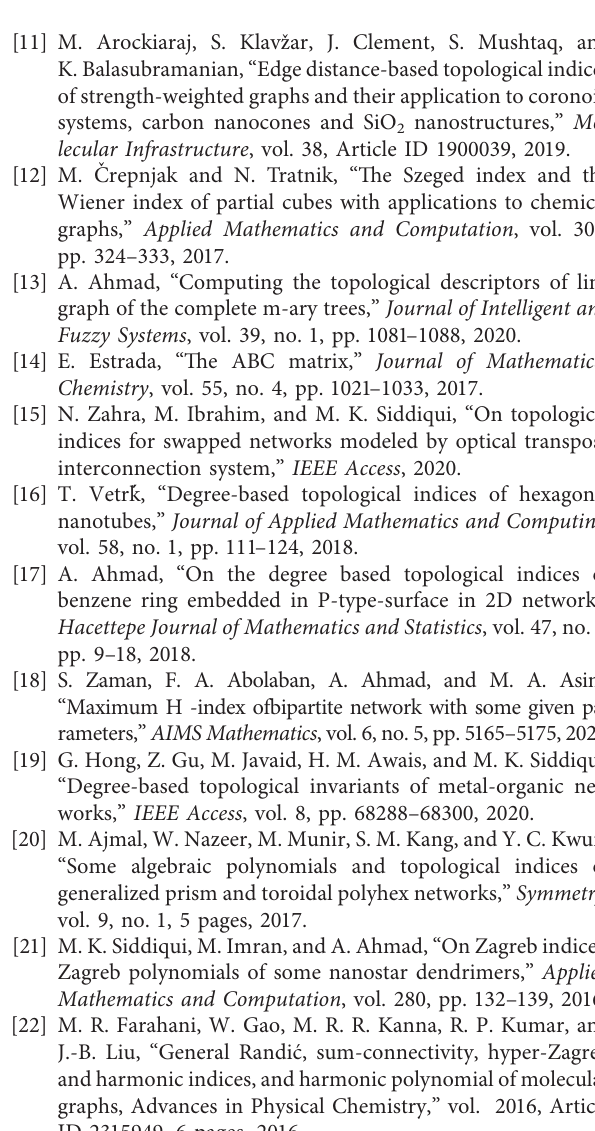
, ABC , GA , H , and χ ev ve ve ve ve